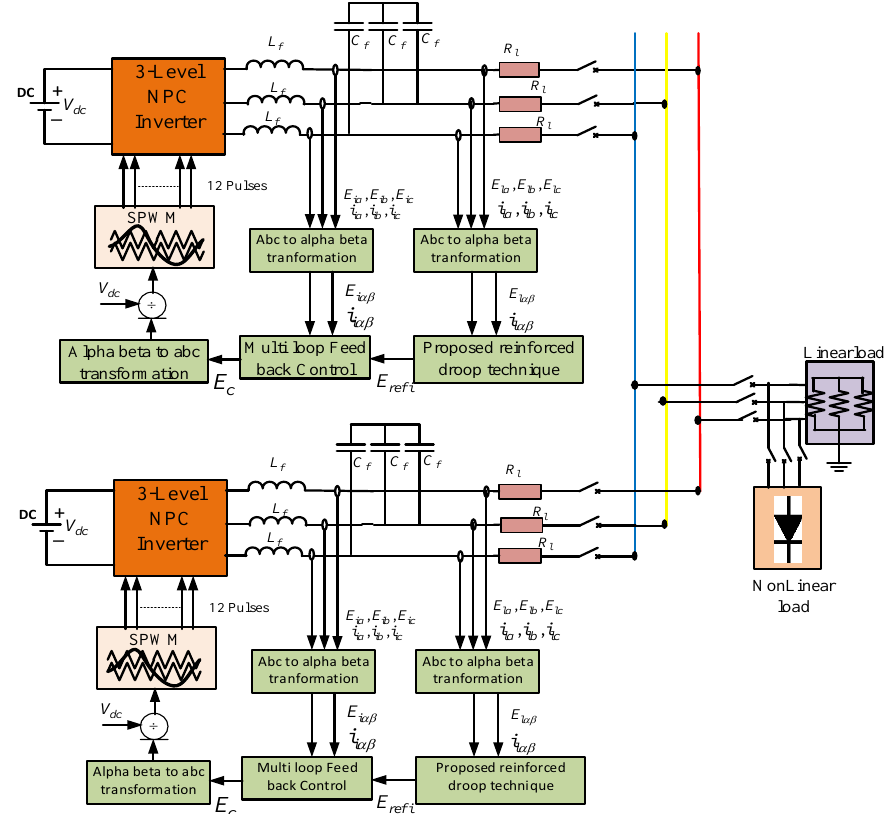
Figure 7. Overall control block diagram of the parallel 3-level NPC inverter for islanded microgrid.